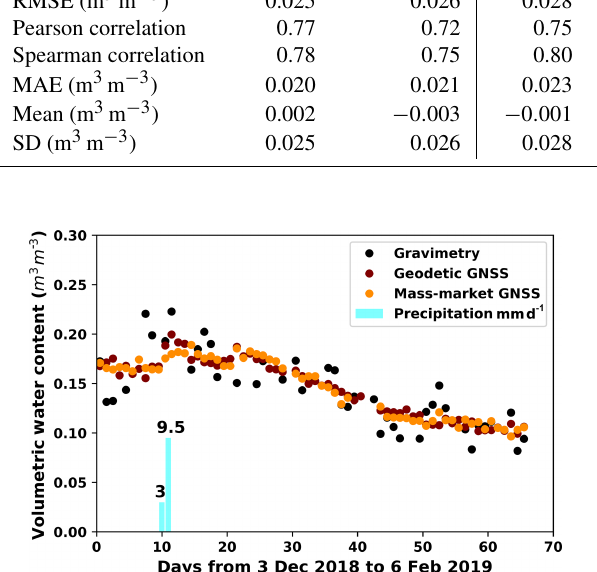
Figure 14. Multi-constellations GNSS (GPS–GLONASS– GALILEO combination) comparison of daily soil moisture. The results of the geodetic and mass-market antennas are compared with the reference gravimetric data